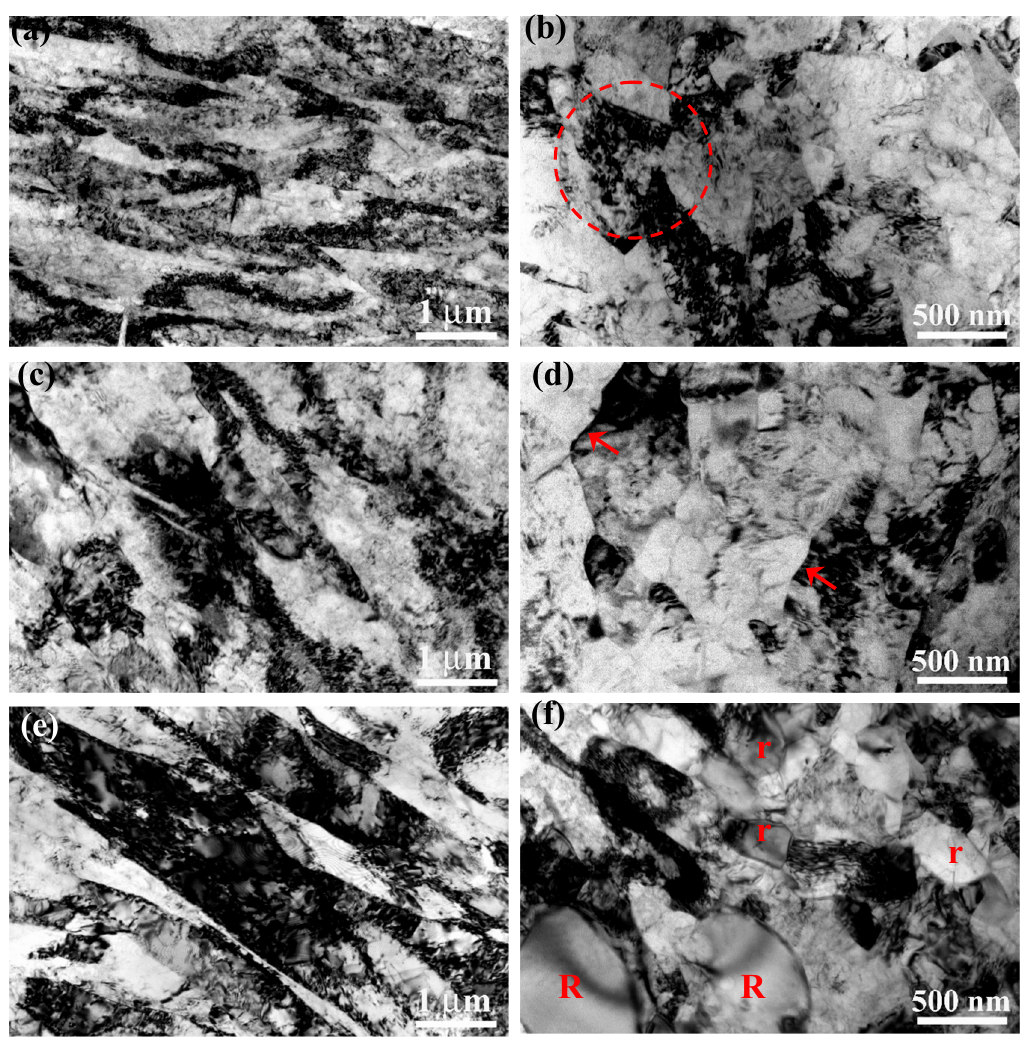
Figure 3. Typical TEM micrographs showing the microstructures on longitudinal section (left side) and transversal section (right side) of the RS-processed samples: ( a , b ) as-received, ( c , d ) RSA450, ( e , f )